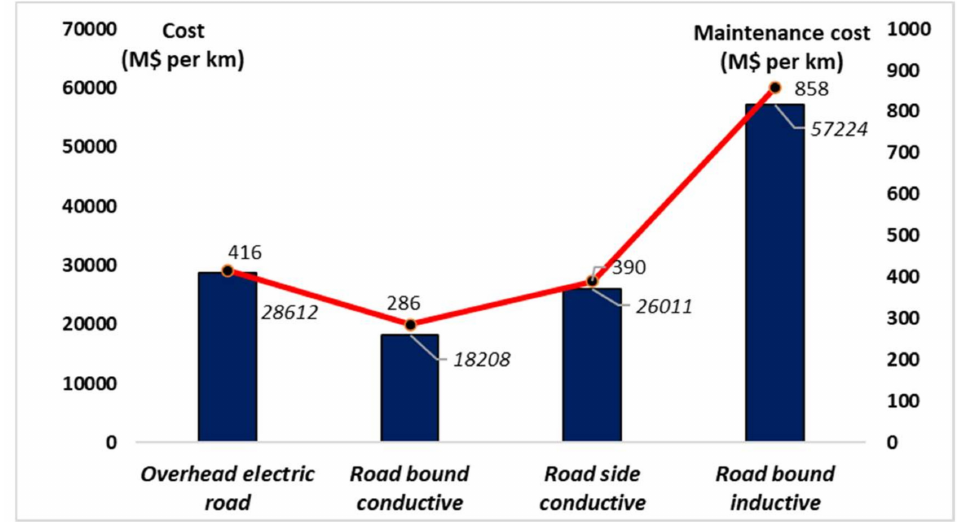
Figure 3. Total investment and maintenance cost to install 26,011 km of ERS in